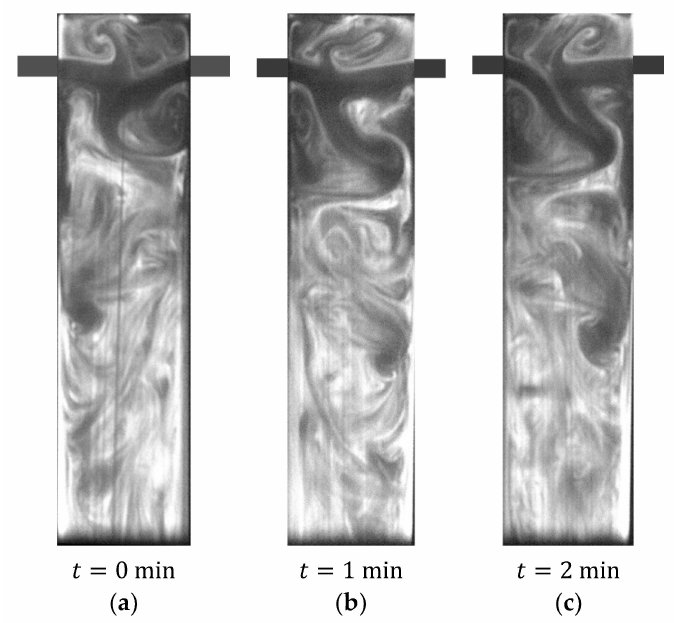
Figure 7. PLIF image obtained with AB-RPLIF method for Re =